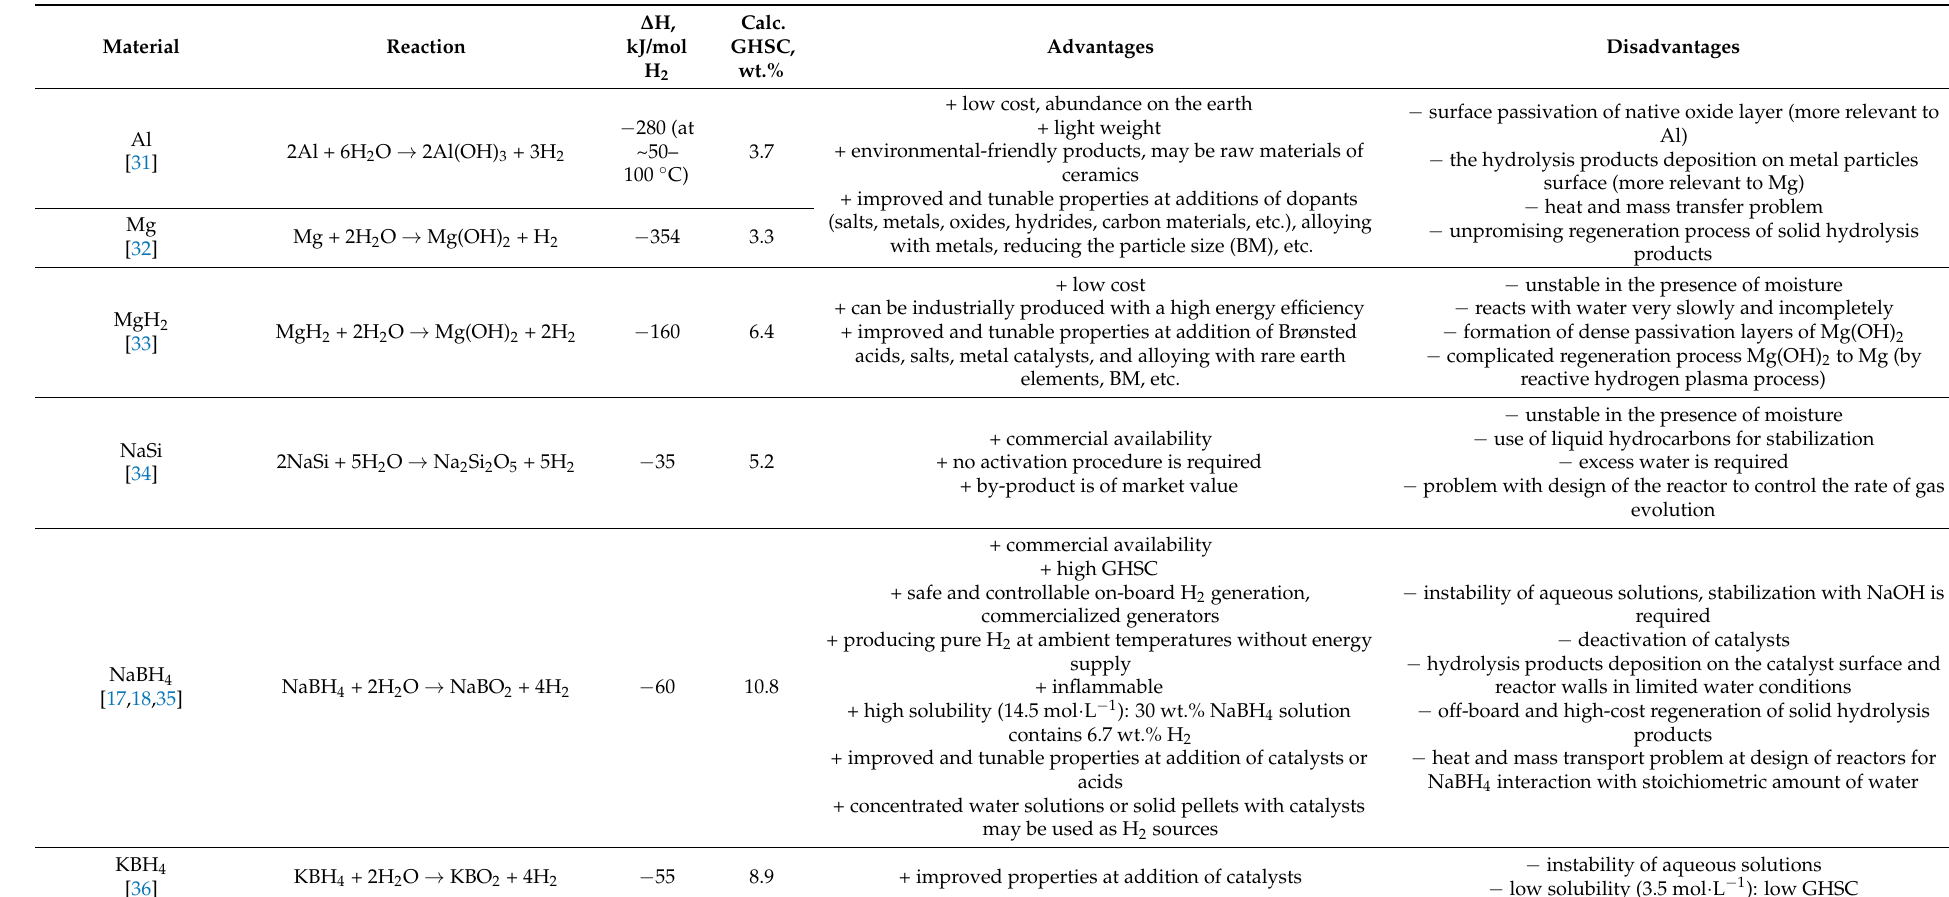
Table 1. Water-reactive materials for hydrogen